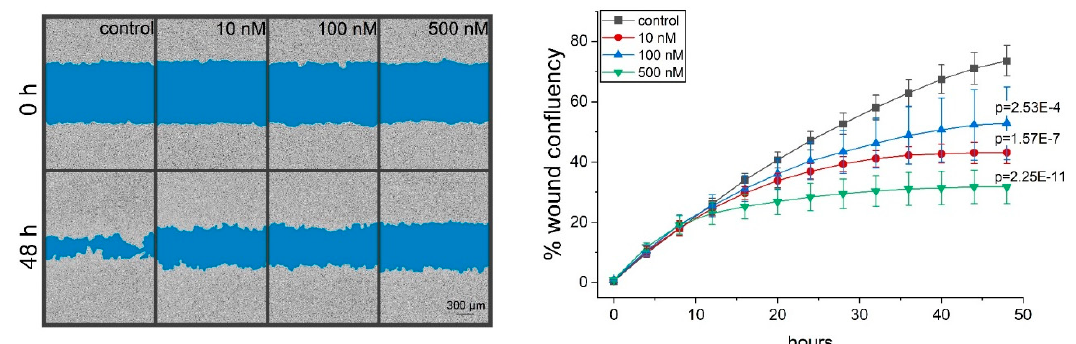
Figure 6. ThioA inhibits cancer cell migration in a scratch wound assay. HCT116 cells were treated with thioA, and wound closure was analyzed in an IncuCyte S3 system over 48 h (right panel). Representative pictures are shown (left panel). Statistical analysis was performed for the last acquired time point using one-way ANOVA followed by Bonferroni’s post-hoc analysis. n = 3 (quadruplicates). 2.5. Thioholgamide A Inhibits OXPHOS-Dependent Atp Production in Macrophages